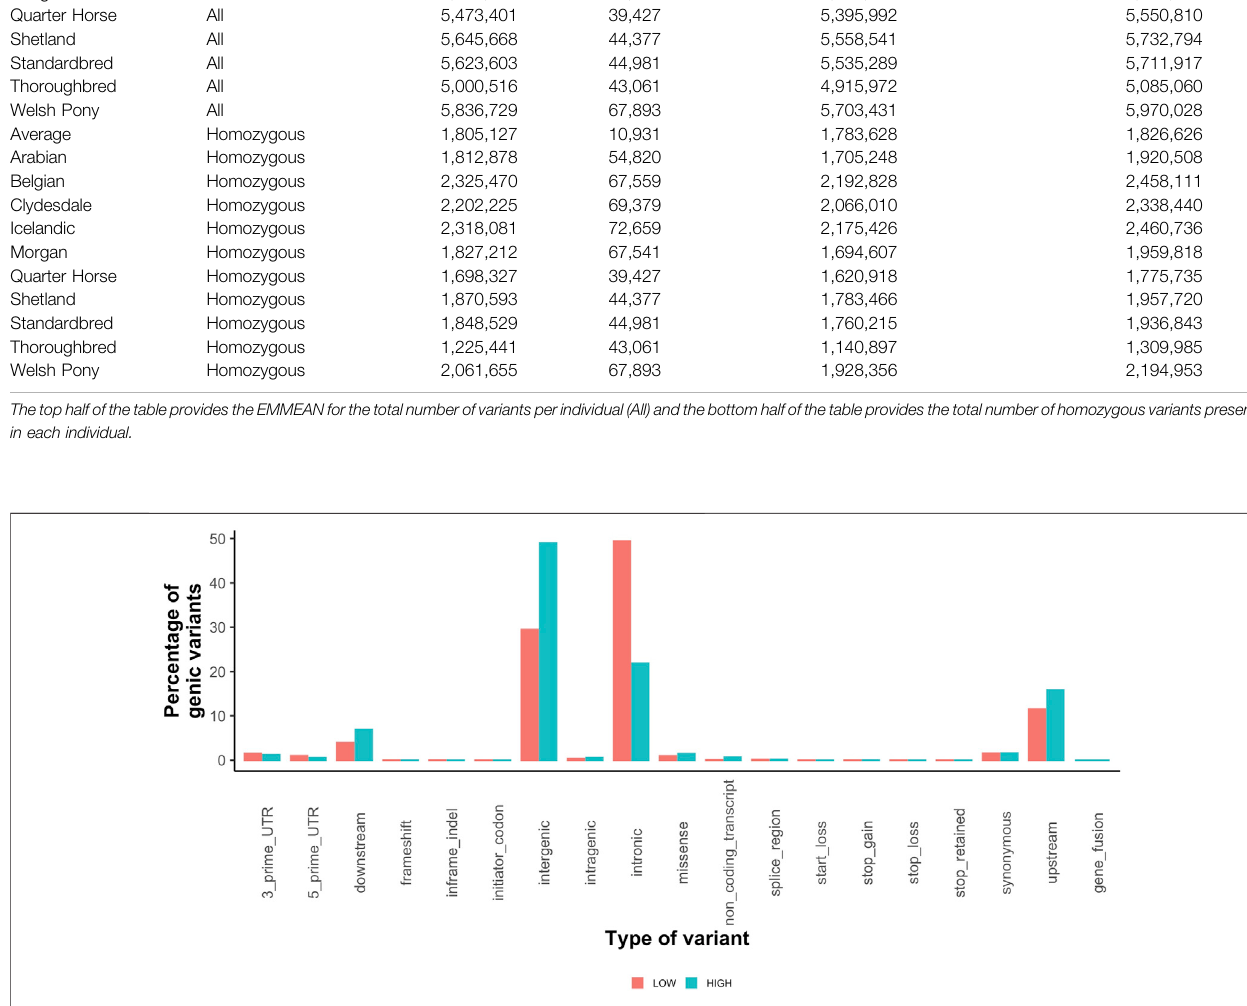
FIGURE 4 | Percentage of coding variants for each type of variant called by SnpEff for low variation regions (orange) and high variation regions (teal).